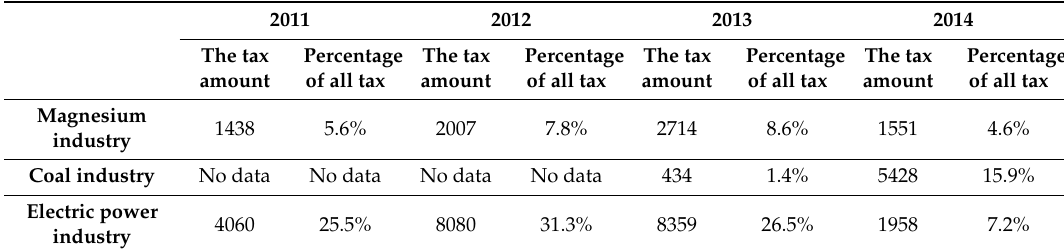
Table 7. The tax from industry in Wutai County from 2011 to 2014.